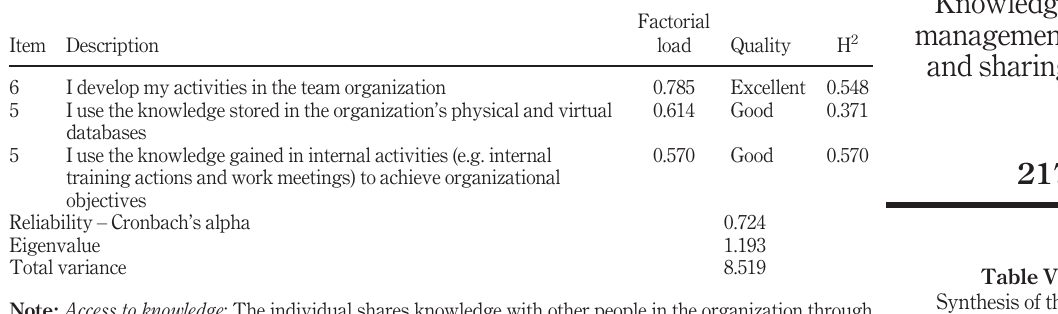
Table VI. Synthesis of the